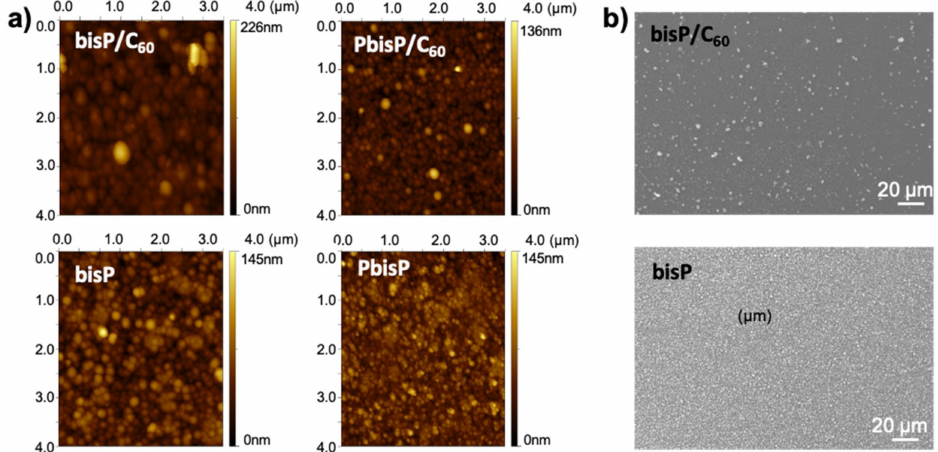
Figure 5. ( a ) AFM images and ( b ) SEM images of electropolymed films onto indium tin oxide (ITO)